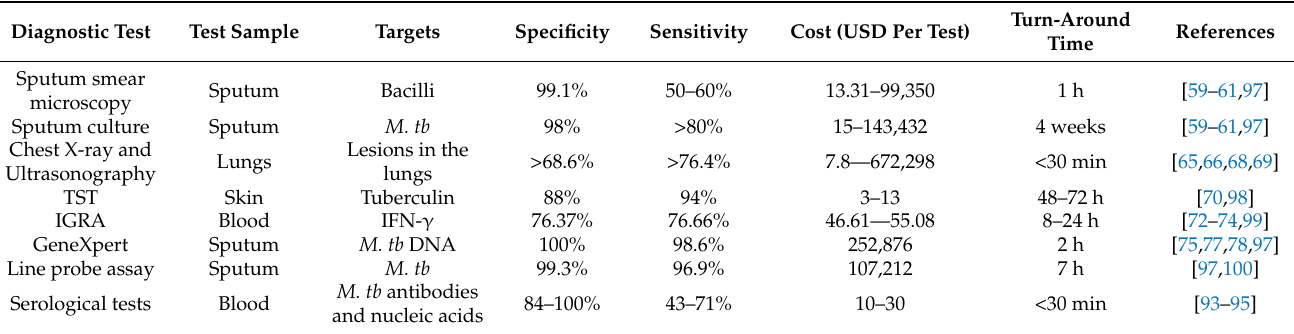
Figure 3. Types of LFAs employed in the detection of molecular targets associated with diseases in biological samples. NALFA detects the presence of nucleic acids while LFIA detects antibodies. Table 2. Properties of current TB diagnostic